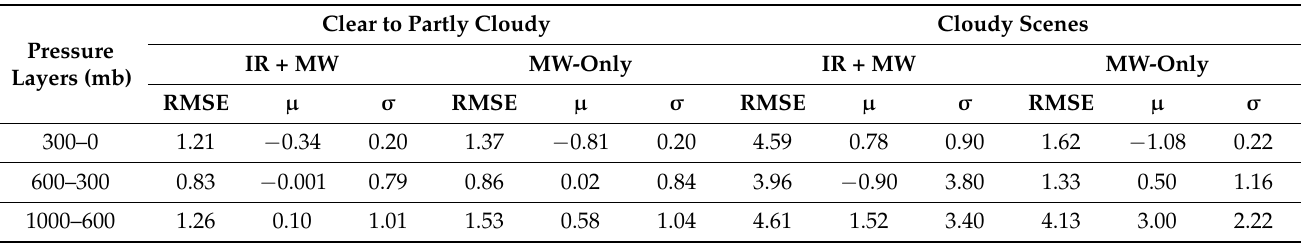
Table 1. Average temperature (K) RMSE, bias ( µ ), and standard deviation ( σ ) for broad pressure layers. Calculations were made using Equations (2)–(5).